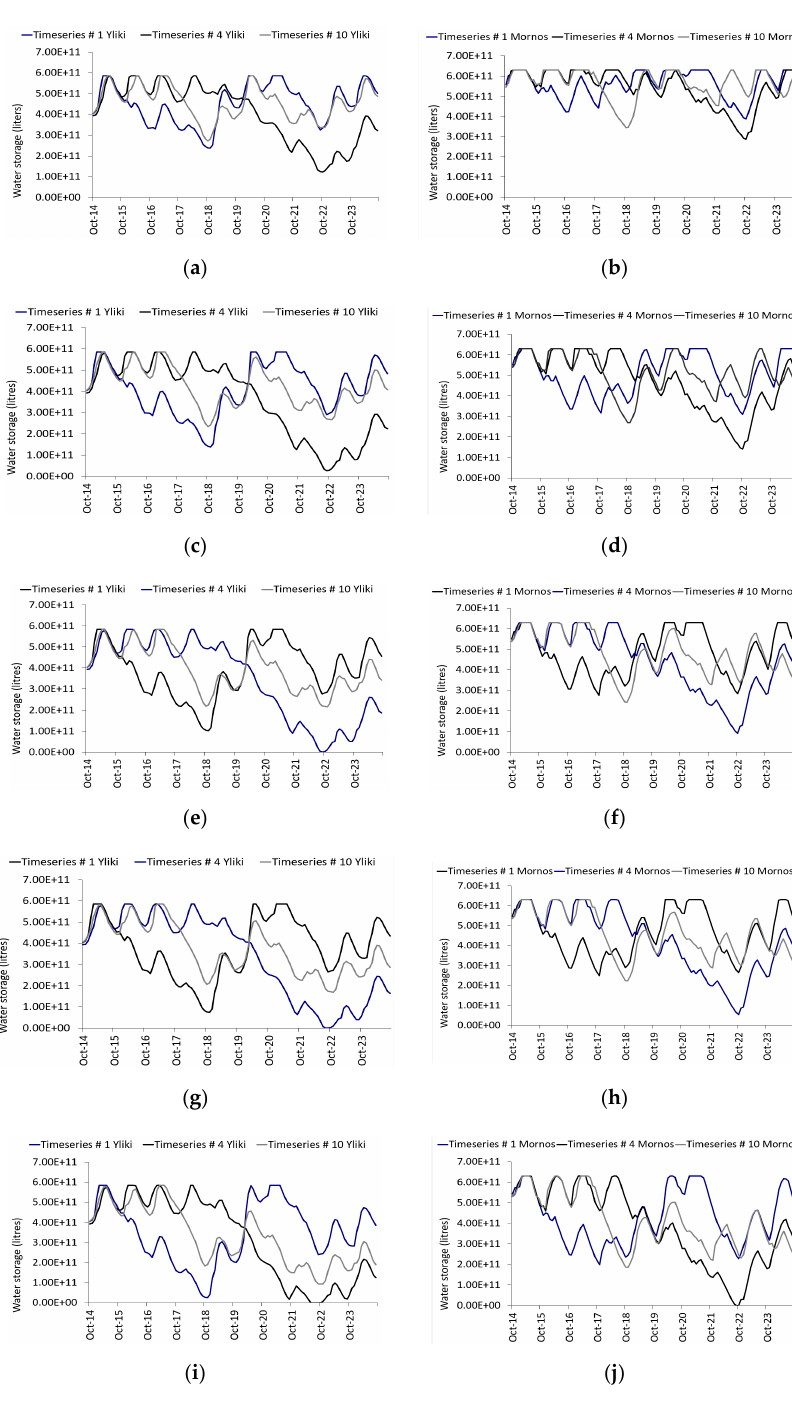
Figure 4. Hylike water storage (a, c, e, g, i) and Mornos water storage (b, d, f, h, j) in liters for the three selected water supply time series and all of the water demand scenarios. (Scenario 1: a, b, Scenario 2: c, d, Scenario 3: e, f, Scenario 4: g, h, Scenario 5: i, j).